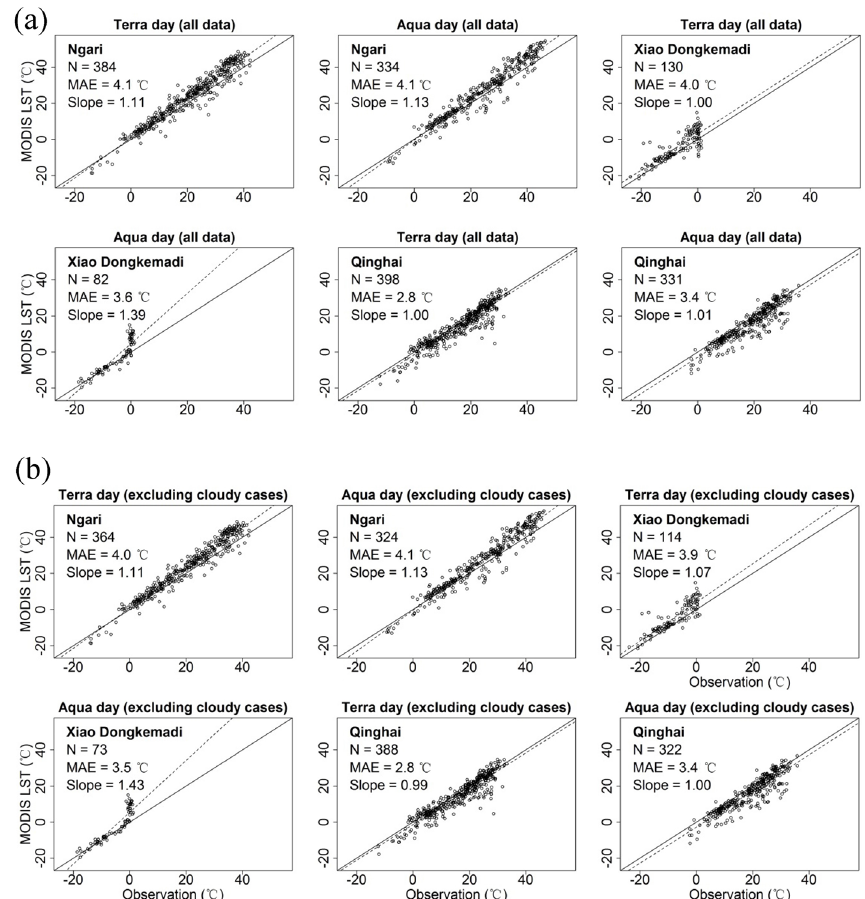
Figure 5. Validation of MODIS daytime LST before (a) and after (b) , excluding cloudy